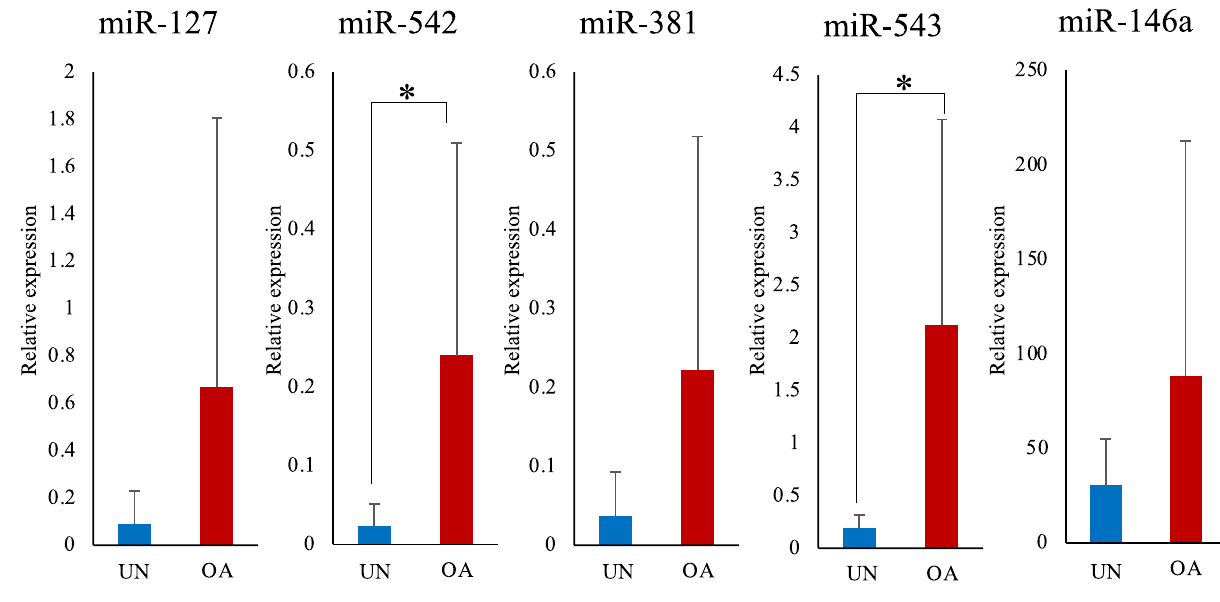
Figure 7. Comparison of miRNA expression level in the synovial fluid between the two groups. The relative expression levels of each miRNA in the synovial fluid in the osteoarthritis (OA) group and the unaffected group were compared. The data are presented as mean ± standard deviation. UN, unaffected group; OA, osteoarthritis group. *: Mean values differ significantly between the groups ( p < 0.05).